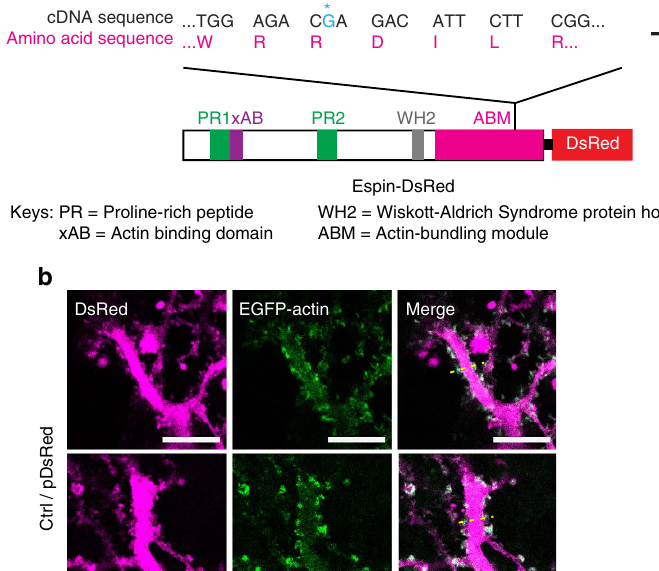
electrophysiological properties of the mutant PCs become abnormal, causing ataxia in the DKO mutants (Fig. 10). Lhx1 and Lhx5 belong to the LIN-11 group of LIM-home- odomain protein family and act as transcriptional activators 29 . Previous studies have shown that Lhx1/5 are functional redundant in the early differentiation of PCs in the embryonic cerebellum 9 and in the maintenance of inhibitory interneurons in the dorsal